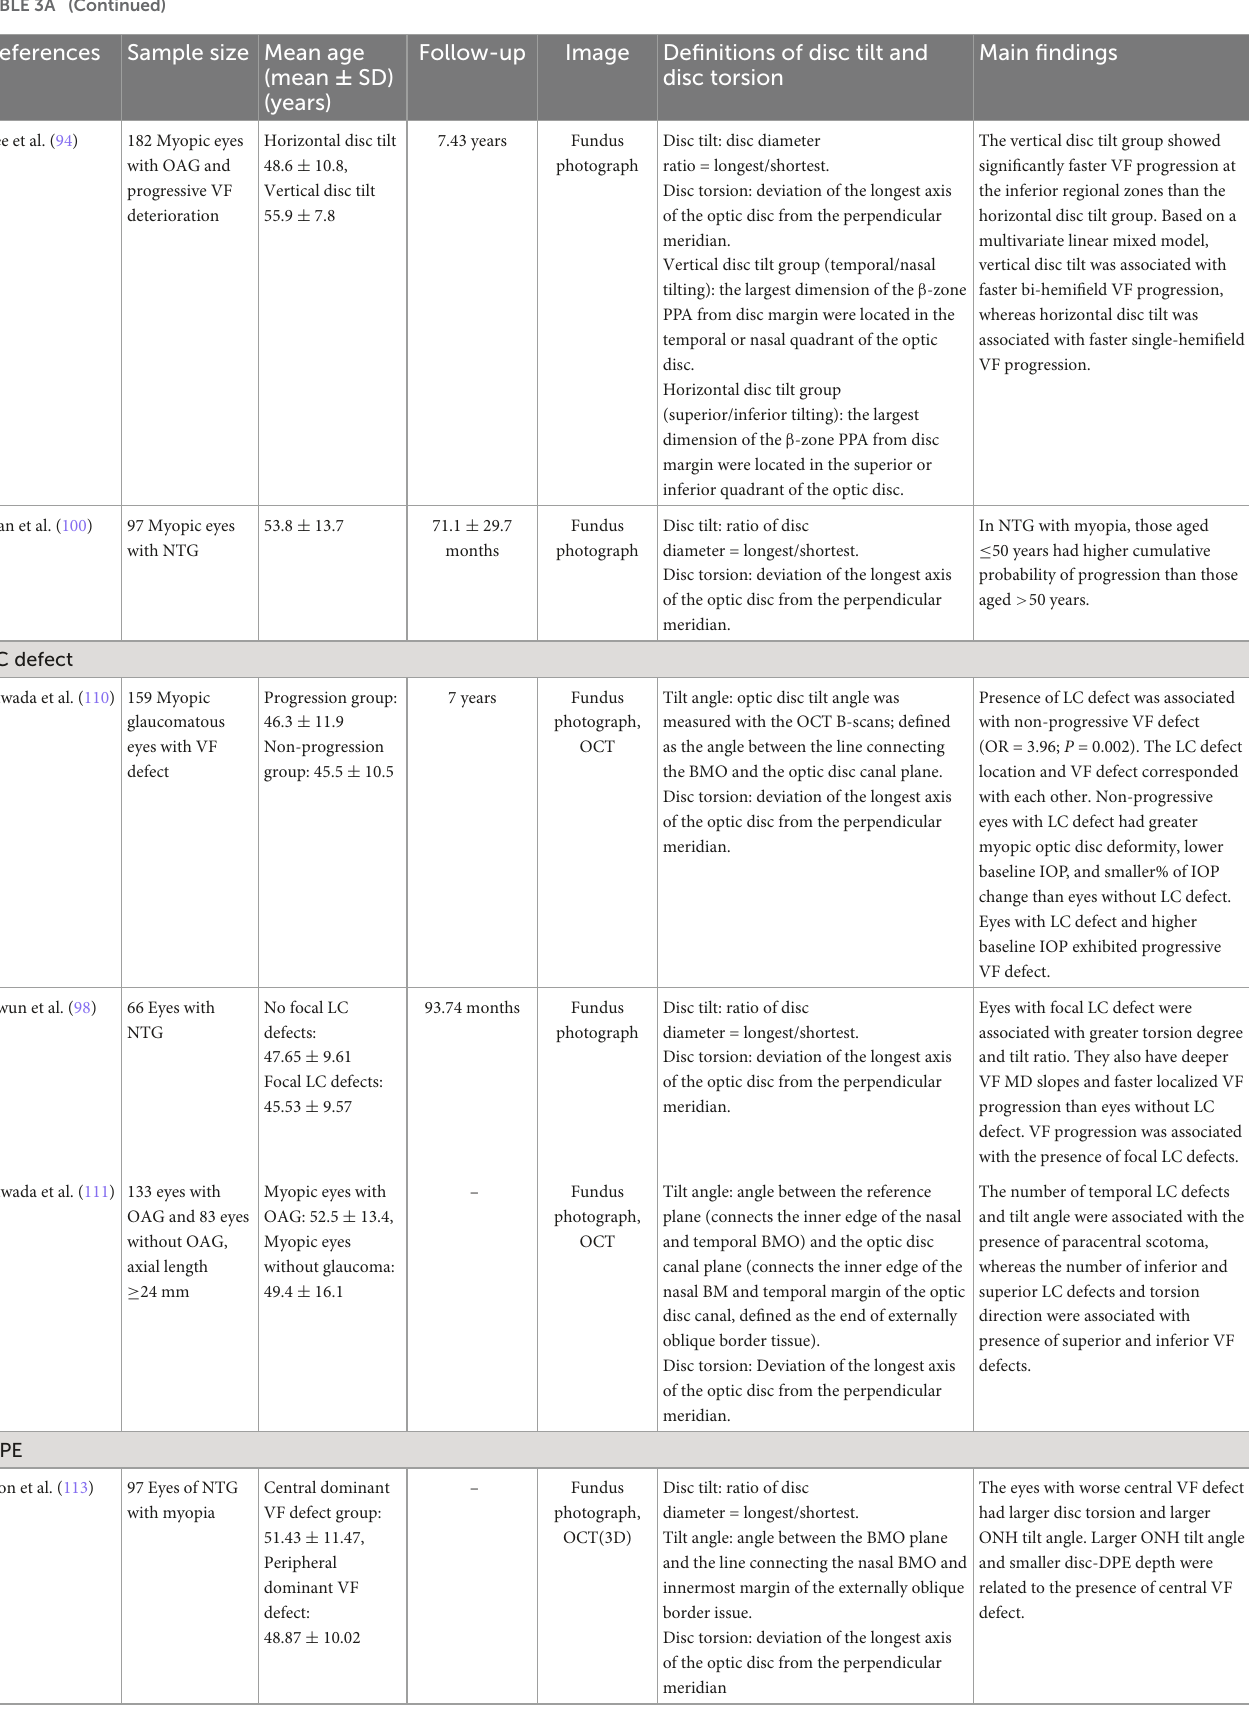
innermost margin of the externally oblique border issue. Disc torsion: deviation of the longest axis of the optic disc from the perpendicular meridian